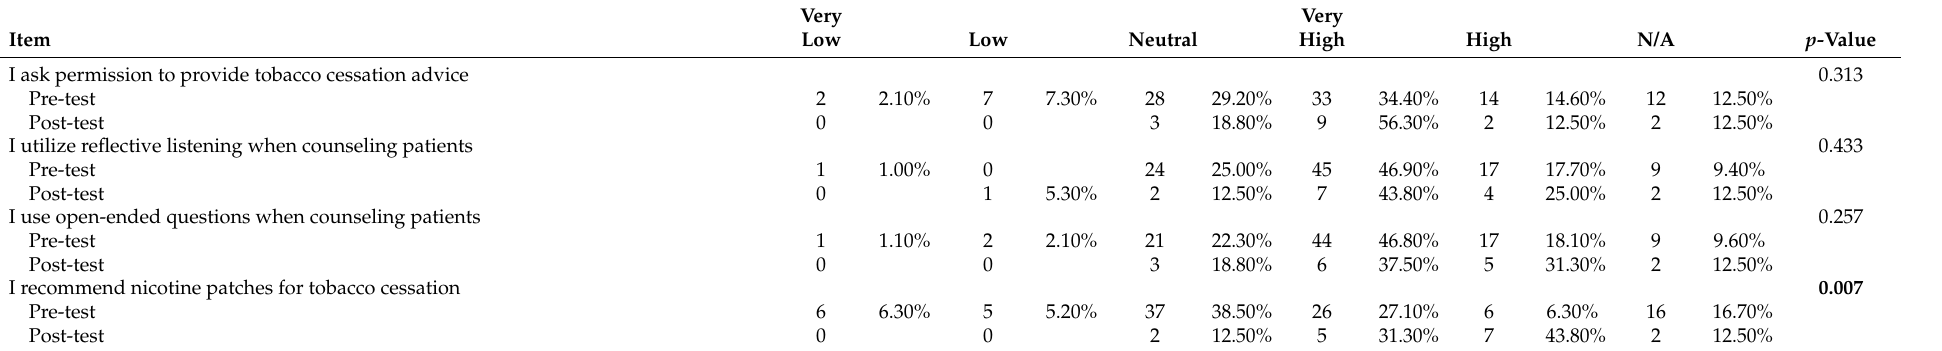
Table 4. Behavioral/outcome practices: Current Practice Changes Between the Pre-test and